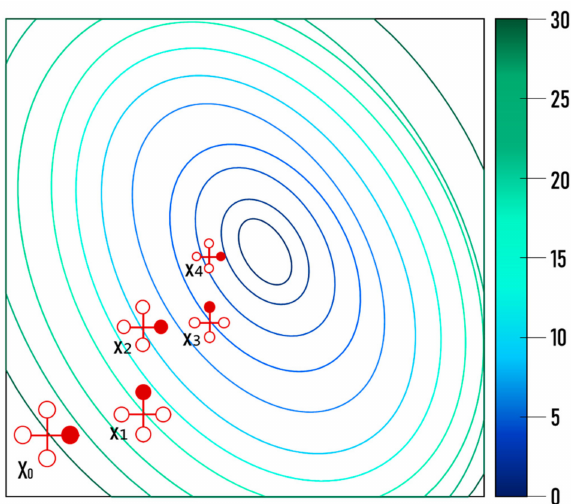
Figure 10. Coordinate search method